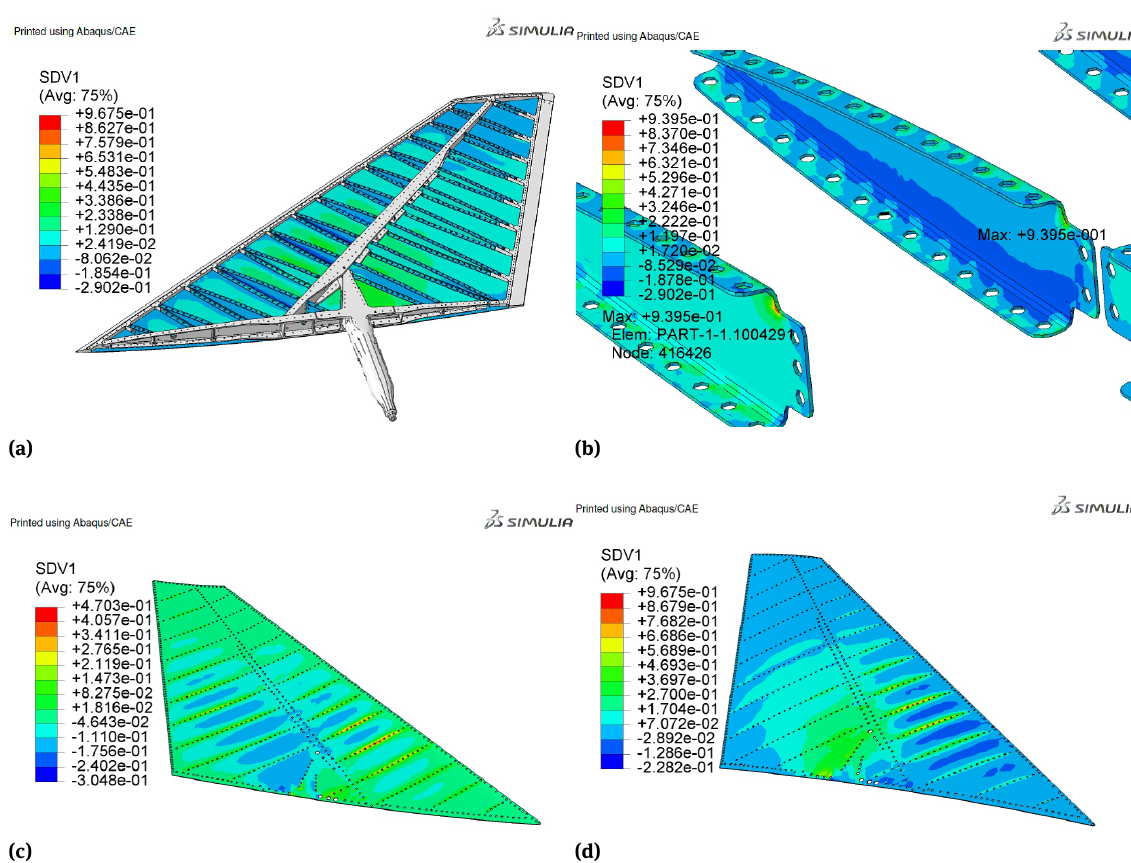
Figure 8: FI Distribution for (a) Full Structure, (b) Ribs, (c) Top Panel and (d) Bottom